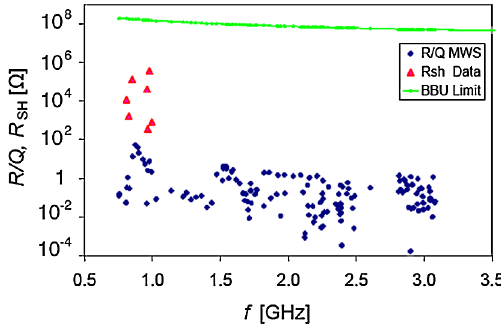
FIG. 9. Simulated R=Q values, transverse shunt impedance values, and the estimated worst-case BBU limit.